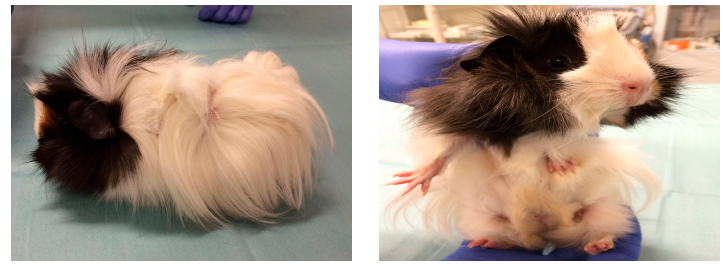
Figure 5. A guinea pig presented as the probable cause of infection by M. canis in a child (case #